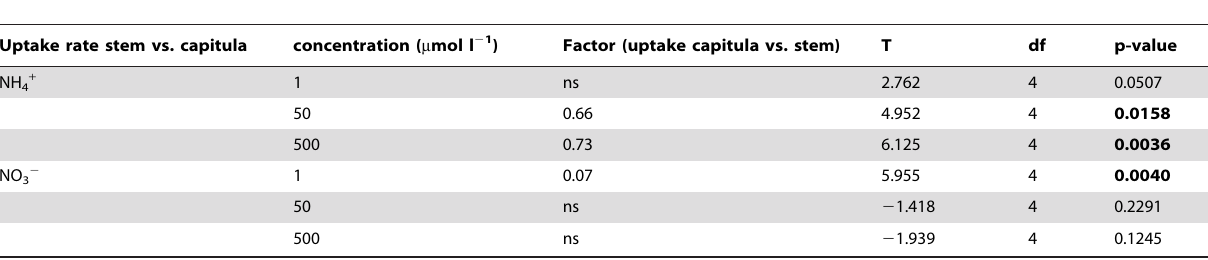
The statistical values are the result of T-tests. Significant differences are printed in bold.